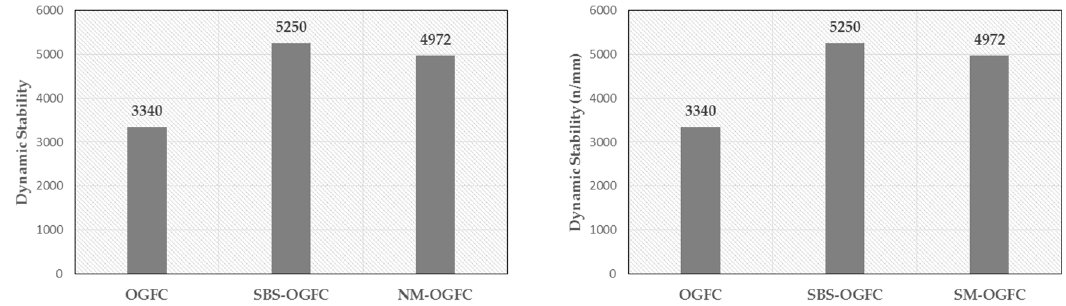
Figure 8. Dynamic stability for all OGFC mixtures.